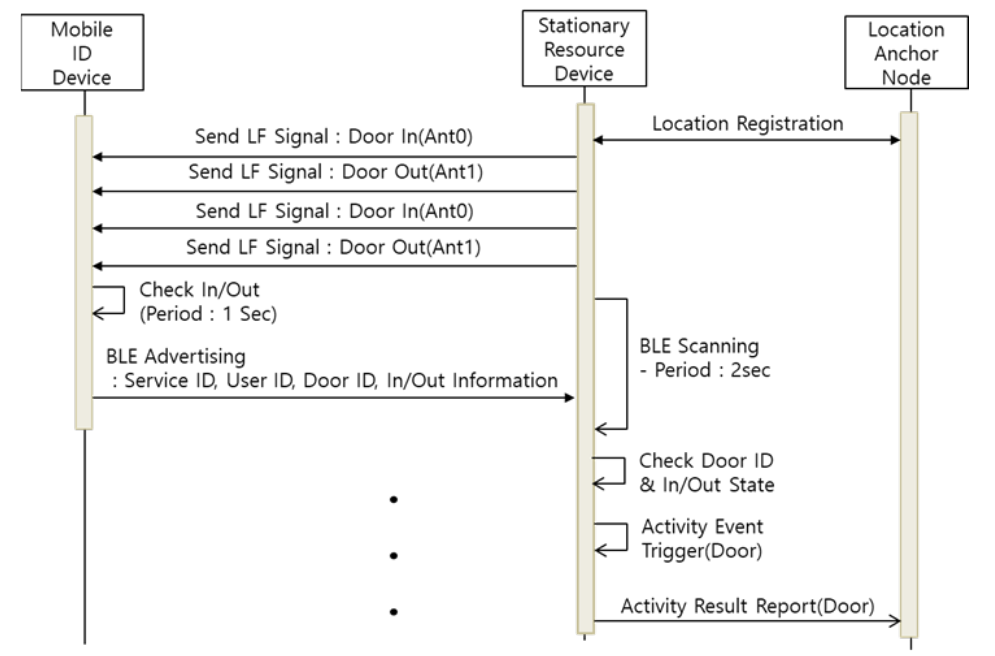
Figure 9. Sequence Diagram of Entrance Recognition System.